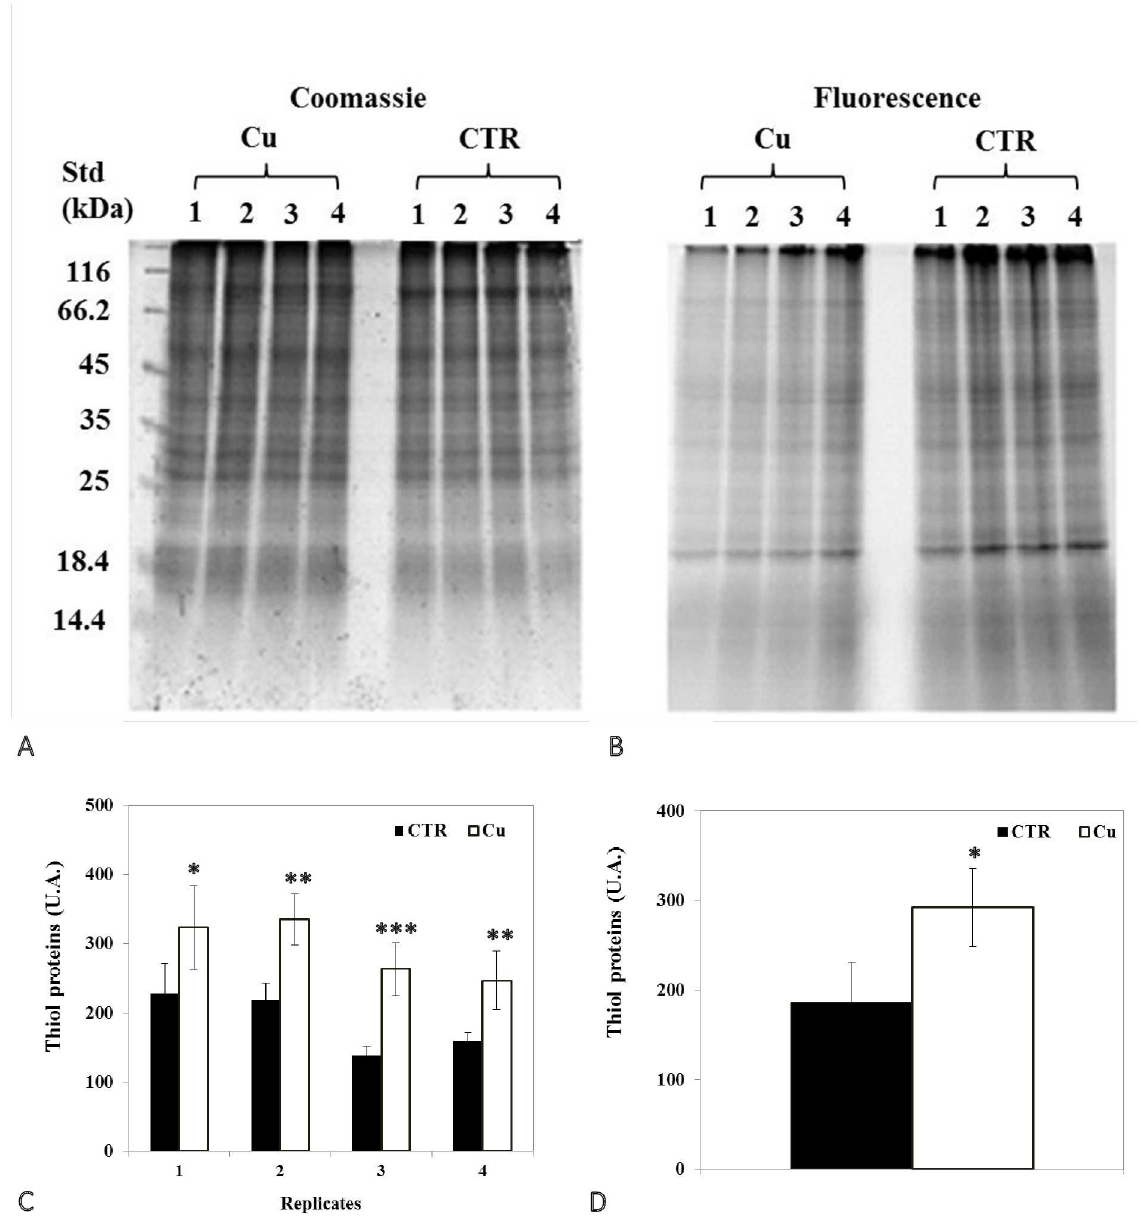
Fig 4. Representative images of 1DE gels of proteins (100 μ g) in seedlings of bean seeds germinated for 3 days. (A) In the presenceof distilled water (CTR) or (B) 200 μ M Cu. Gels were stained with Coomassie G-250 (scanned with GS-800 calibrated densitometer) and with IAF labeling (scanned with Typhoon 9400scanner). Total opticaldensities for each lane obtainedfrom IAF stainingwere normalized with those from CoomassieG-250 stainingof the same gel. (C, D) Levels of proteins containing thiol groups. Valuesshown are (C) means of 4 biologicalreplicates( ± SD) numbered from 1 to 4, and (D) means of 4 technicalreplicates( ± SD). Each measurement was performed in an extract obtainedfrom severalseedlings. Analyseswere performed using ANOVA, student’s T test; * p < 0.05, ** p < 0.01, *** p < 0.001.